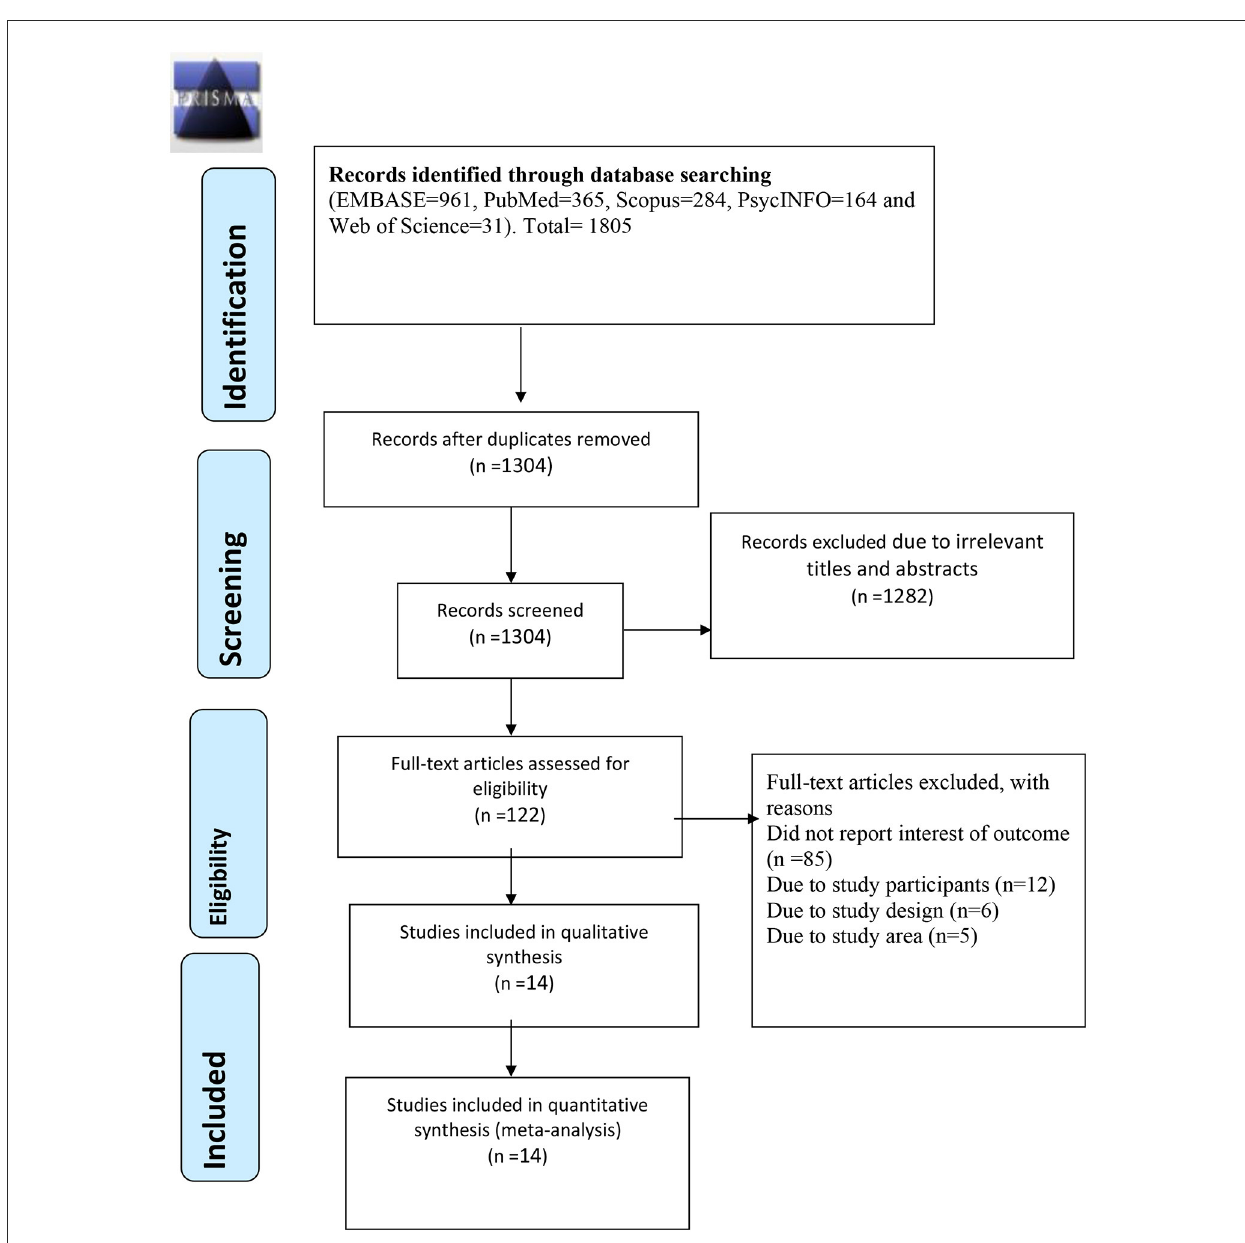
FIGURE1 A flow diagram of the process of article identification and selection.